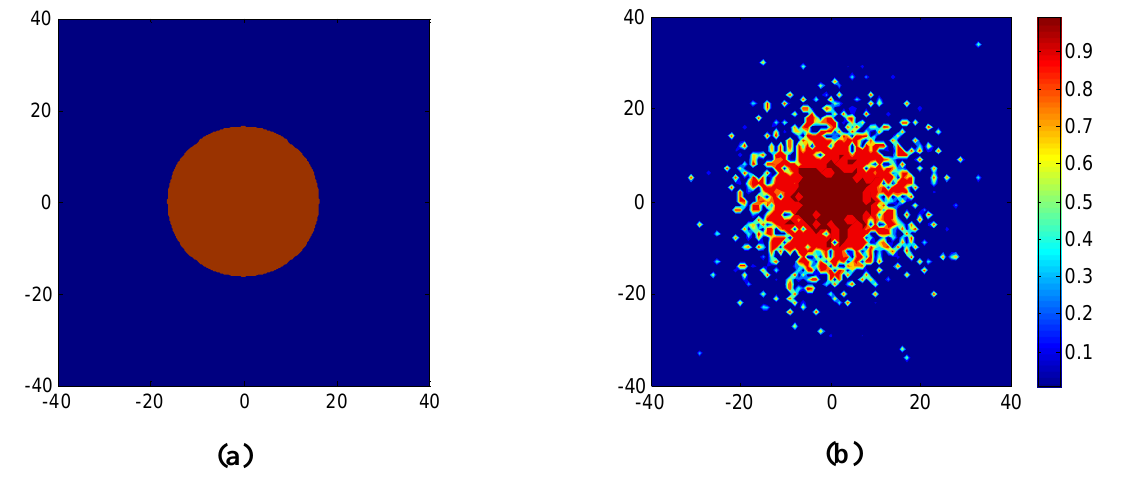
Figure 3. Contour plot for different link models. (a) Boolean disk model . (b) Log-normal shadowing based probabilistic